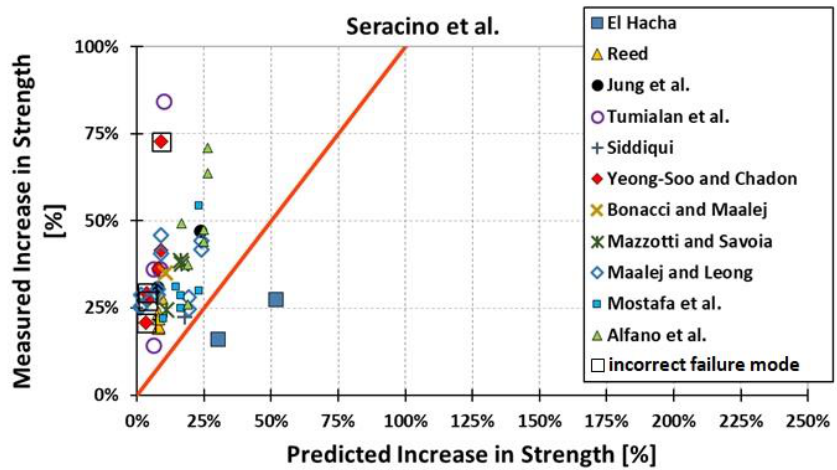
Figure 15. Measured increase in flexural strength versus Seracino et al. model prediction.